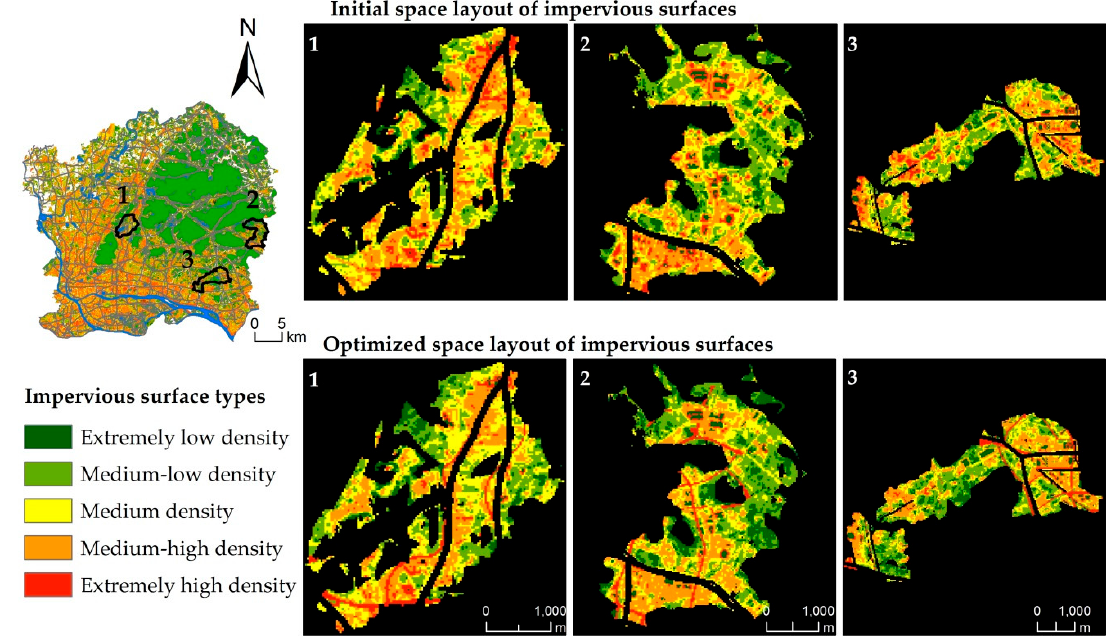
Figure 9. The demonstration of optimal results in runoff plot scale.